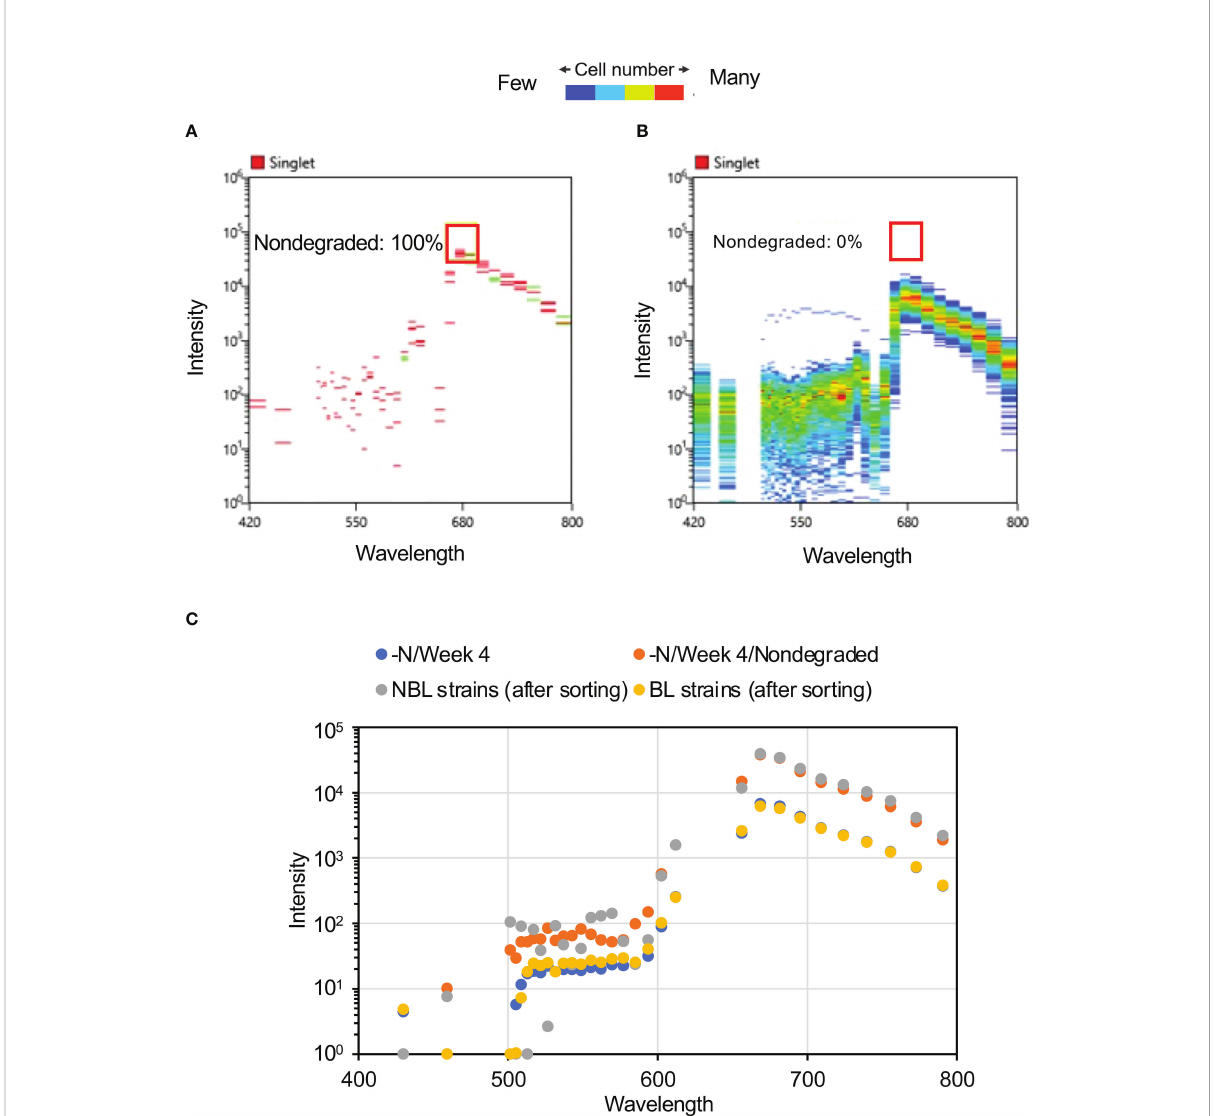
FIGURE 5 Auto fl uorescence spectra of candidate nonbleaching cells. (A) Auto fl uorescence spectrum derived from single cells of four nonbleaching candidate strains after four weeks of N-depletion. The red box and number denote area corresponding to the nondegraded group and the proportion falling within the red box. (B) Auto fl uorescence spectrum derived from single cells of 703 bleaching candidates after four weeks of N-depletion. None of these cells shared the same auto fl uorescence as the nondegraded group. (C) Mean auto fl uorescence intensity of each culture or sorted cell. The post-sorting values for the nonbleaching and bleaching strains are mean values at each of the wavelengths shown in panels (A) and (B) . The graphs of – N/Week 4 and – N/Week 4/Nondegraded are the same data shown in Figure